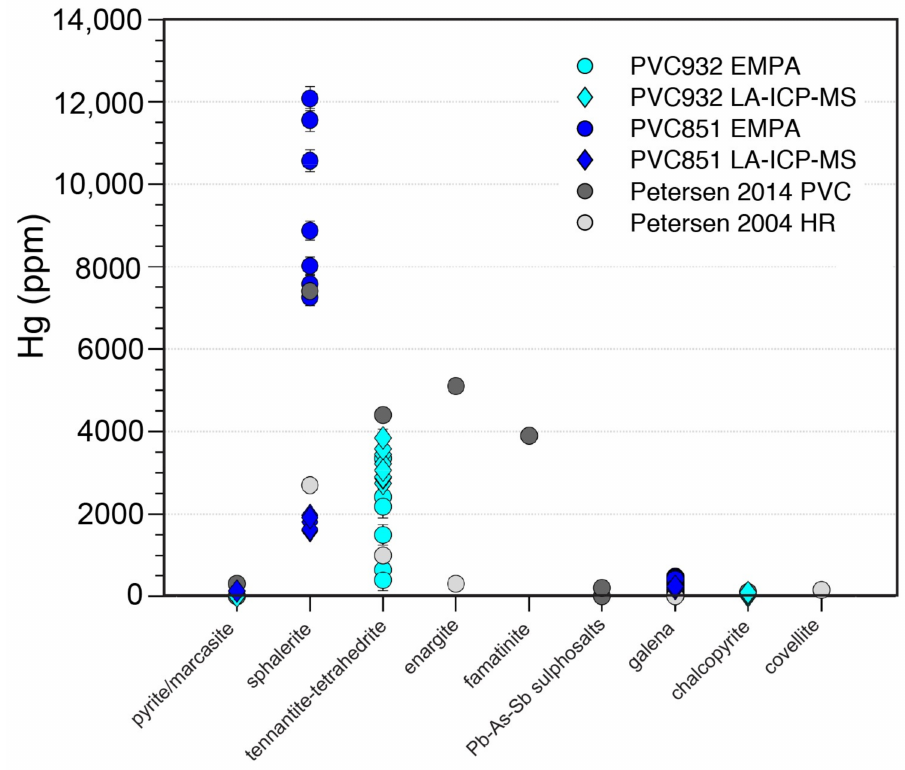
Figure 7. Hg (ppm) concentrations in pyrite, tennantite-tetrahedrite, sphalerite and galena from Palinuro based on EMPA and LA-ICP-MS analysis. Shown for comparison are Hg concentrations in a range of sulfide and sulfosalts minerals from Palinuro and Hook Ridge analysed by Petersen et al. (2014) [84] and Petersen et al. (2004)